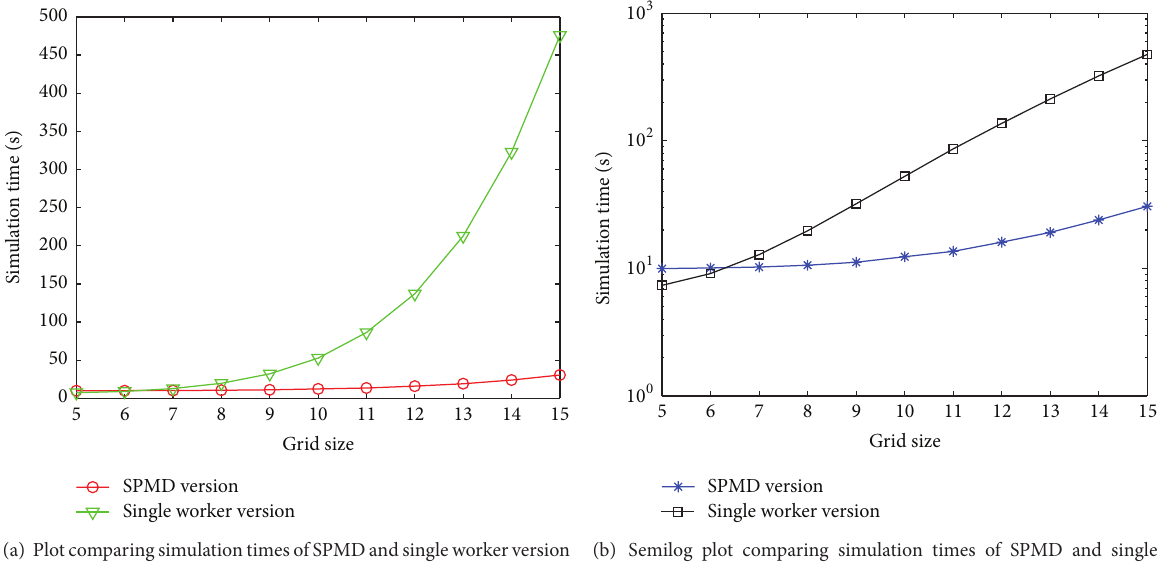
Figure 6: Comparison of simulation times for a sequential and parallel PBM